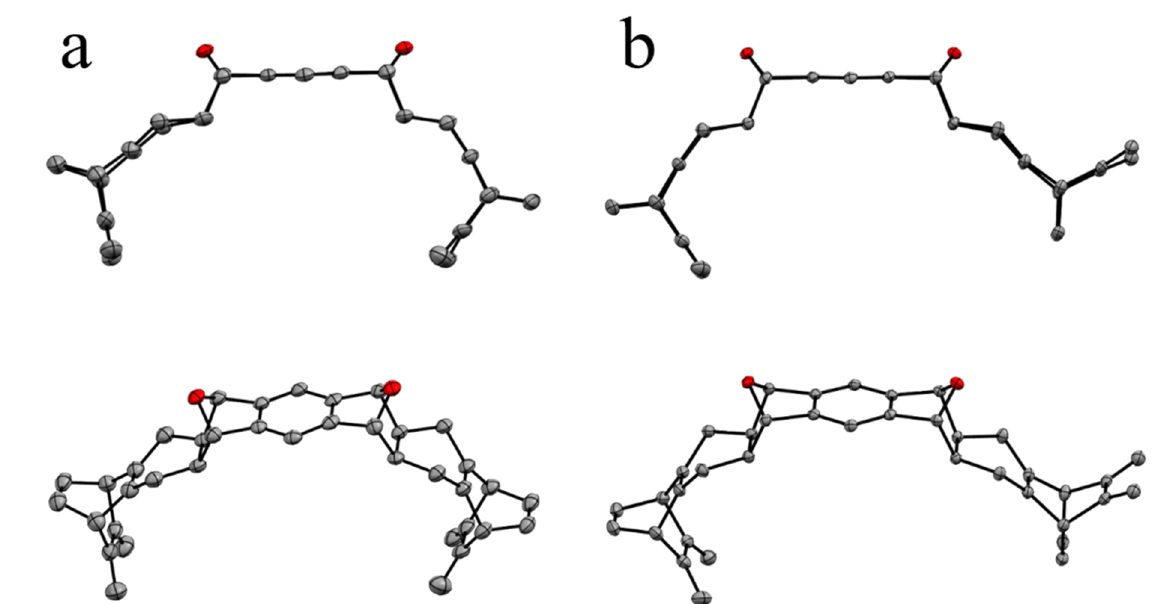
Figure 2. X-ray molecular structures of ( a ) 6a and ( b ) 6b (50% thermal ellipsoids; side views ( top ) and perspective views ( bottom ); hydrogen atoms are removed for clarity.